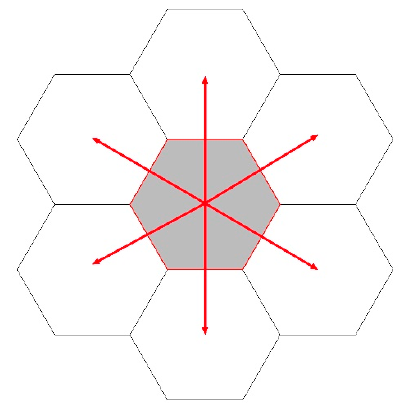
Figure 2. Axis alignment for a hexagonal-shaped grid.